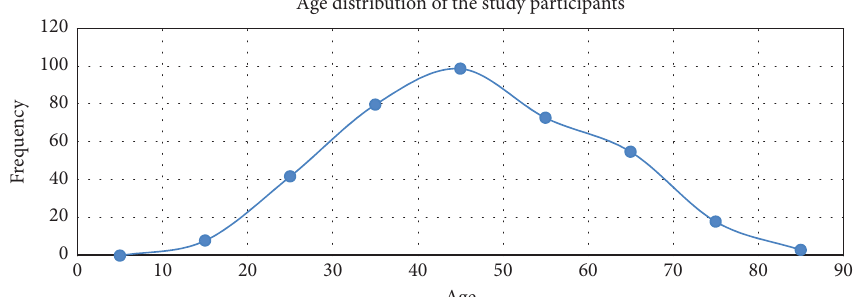
Figure 2: Age distribution of patients with precontrast and portal venous phase abdominal CT scan imaging at TASH, 2020–2022 G.C.